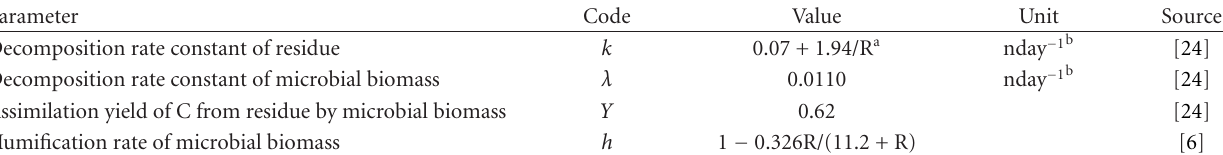
Table 2: Common parameters in the residue decomposition model for the two experimental datasets. Parameter